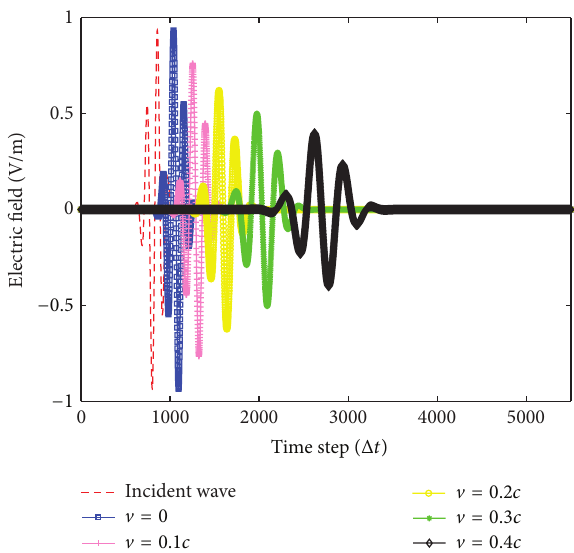
Figure 9: The time-domain scattered waveforms of the moving conducting surface excited by the modulated Gaussian pulse.